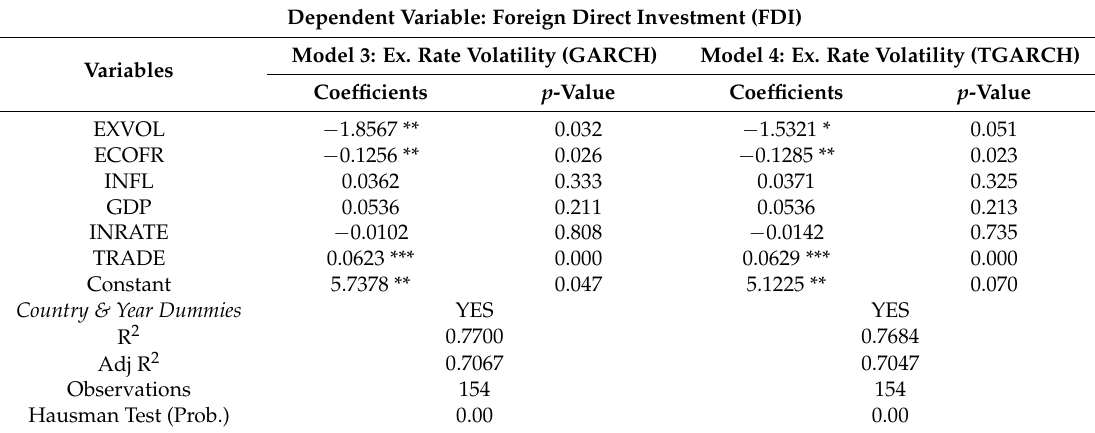
Table 6. FDI and Exchange Rate Volatility: Aggregate (Panel) Level